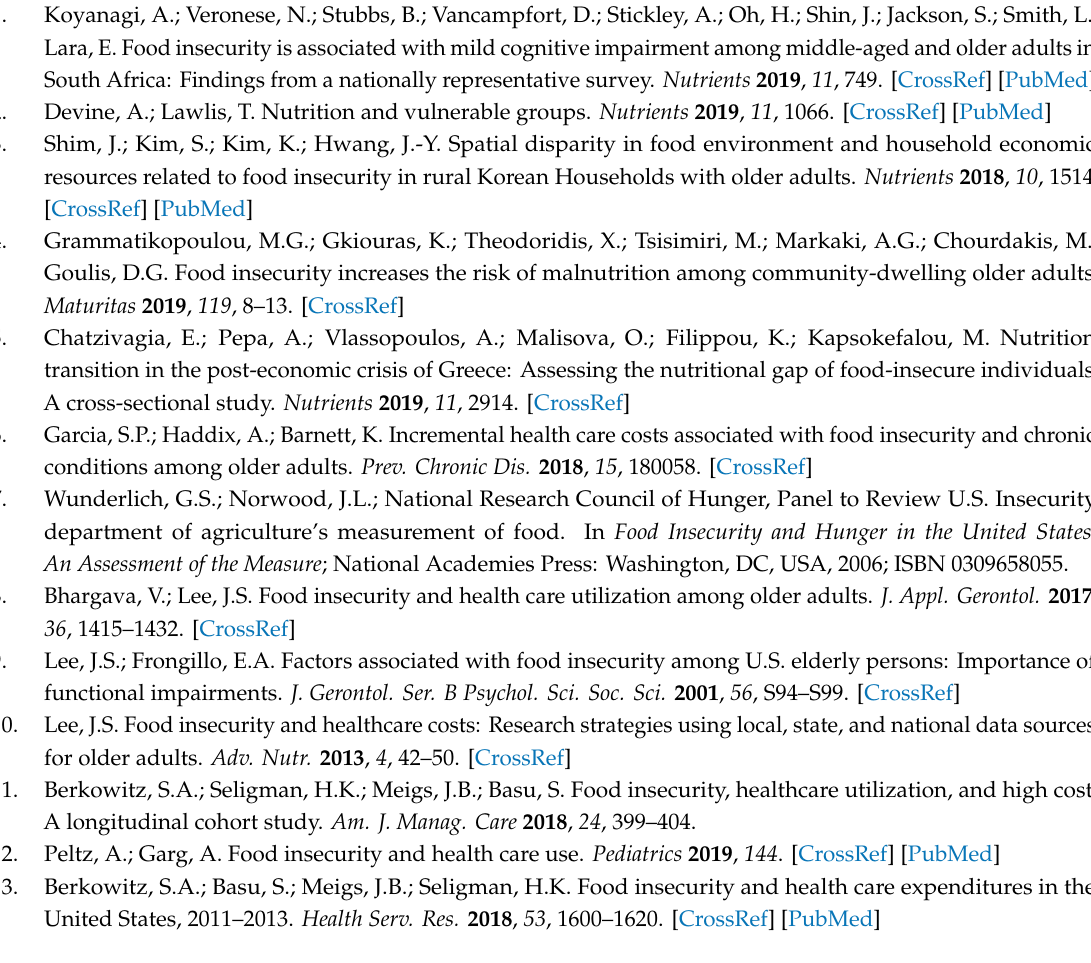
Table S1: Sensitivity analysis: multiple logistic assessment of well-nourished ( n = 36) versus malnutrition risk ( n = 85)